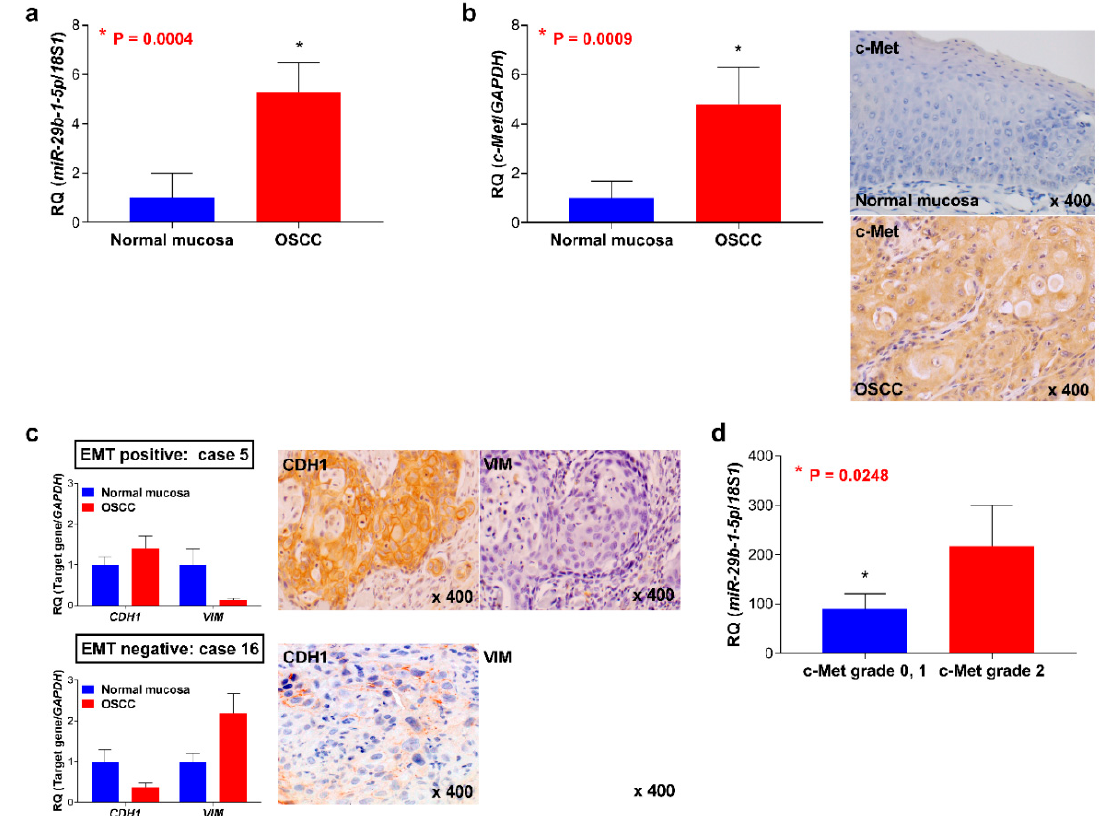
Figure 1. Analyses of the expression of miR-29b-1-5p and c-Met and the status of the epithelial- mesenchymal transition (EMT) in patients with oral squamous cell carcinoma (OSCC). ( a ) Levels of expression of miR-29b-1-5p in OSCC and normal oral mucosal tissues. Representative examples of c-Met expression ( b ) and EMT status ( c ) in OSCC tissues. ( d ) The levels of miR-29b-1-5p were significantly associated with the c-Met immunohistochemical grade ( p = 0.0248).